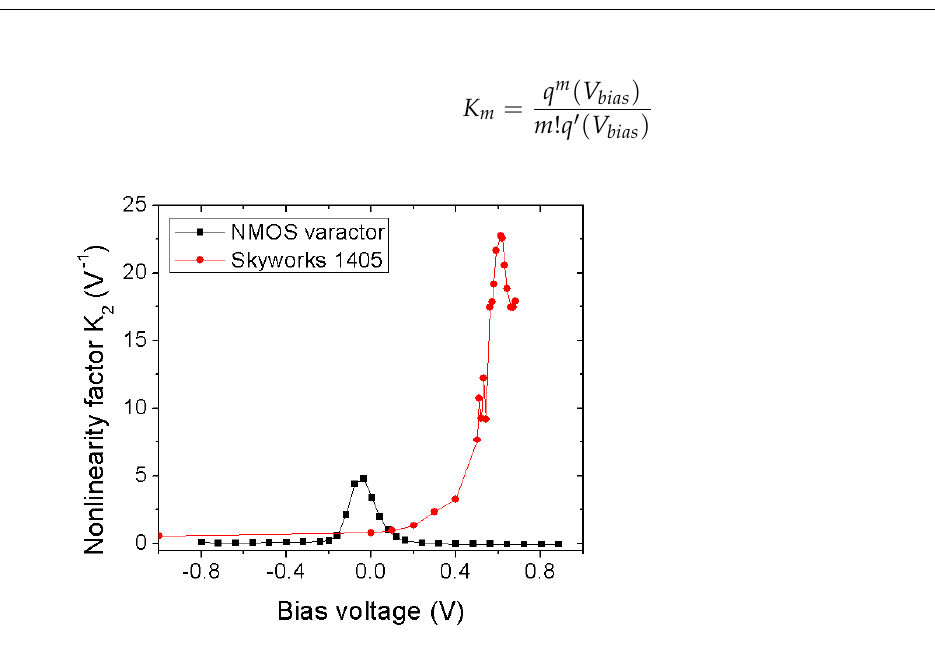
Figure 5. Second order nonlinearity factor ( K 2 ) variation at different DC bias